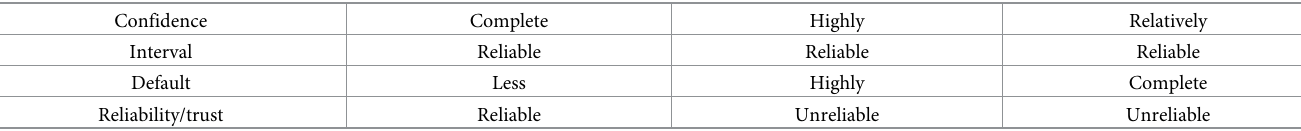
Table 2. Trust classification of trusted entities.